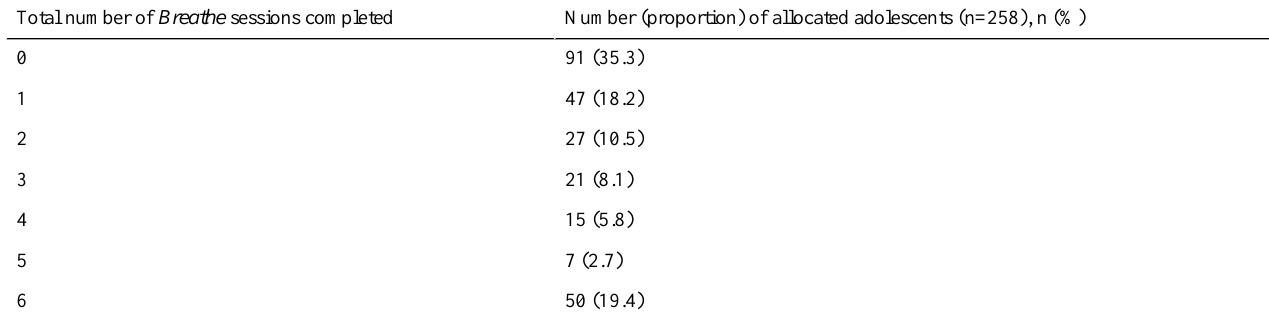
Table 4. The total number of Breathe sessions completed by allocated